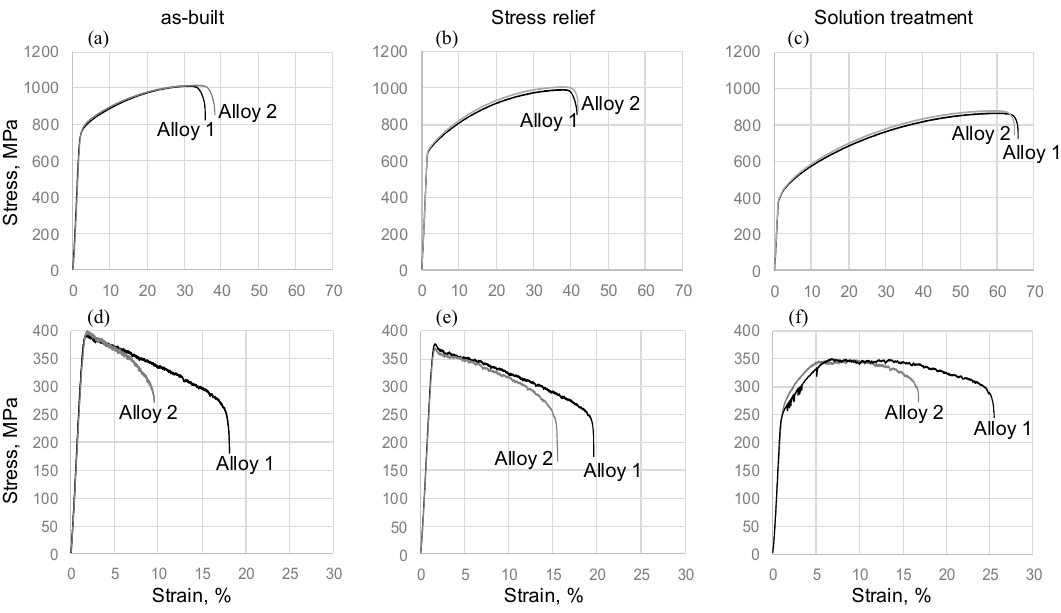
Figure 11. KAM maps (ZX plane) after ( a , b ) SR and ( c , d ) ST treatments of ( a , c ) Alloy 1 and ( b , d ) Alloy 2.